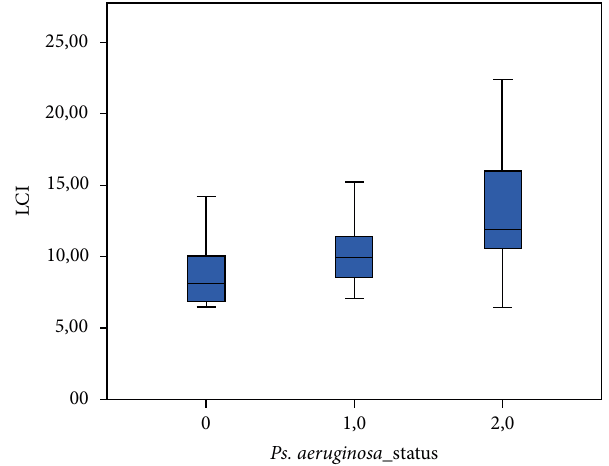
Figure 2: LCI among the three groups of patients. (0: patients not colonized, 1: patients intermittently colonized with P. aeruginosa , 2: patients chronically colonized with P. aeruginosa ).